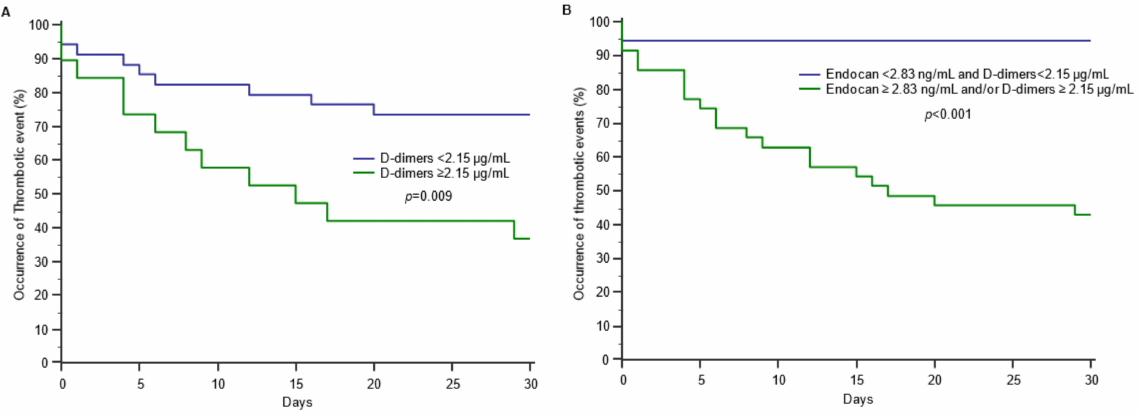
Figure 2. Occurrence of thrombotic events according to D-dimers concentration ( A ) and to the combination of D-dimers and endocan ( B ) in patients with